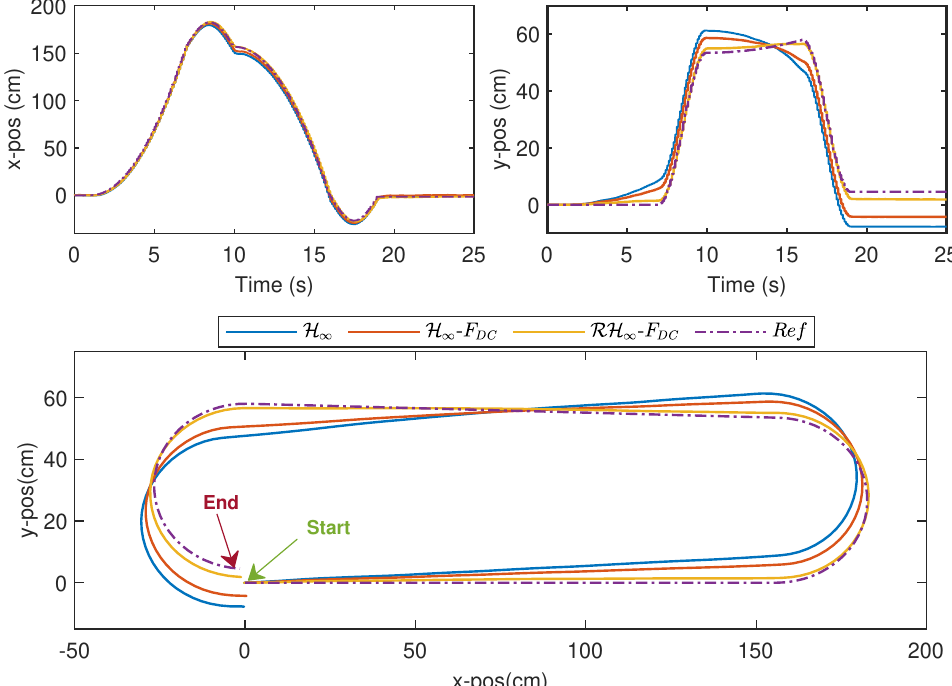
Figure 15. Exp. 2: Trajectories of the WMR in the x-direction (top left), y-direction (top right), and the [ X , Y ] plane